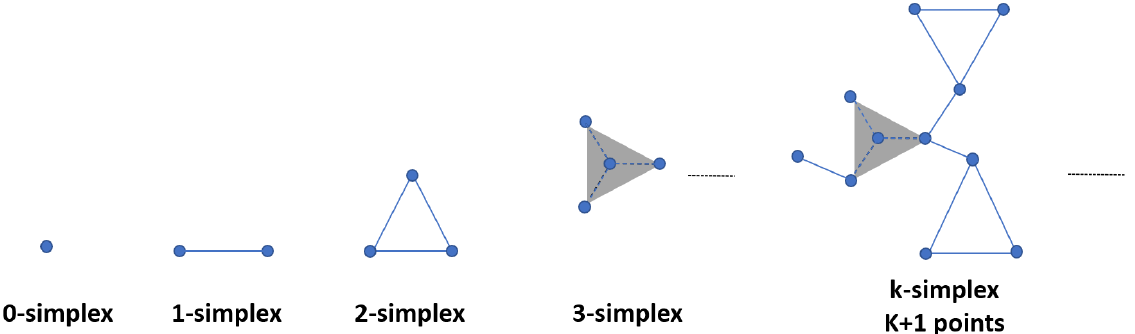
Figure 1. Gradual construction of various simplices (0-Simplex, 1-Simplex, 2-Simplex, . . .) eventually gives way to a Simplicial Complex.